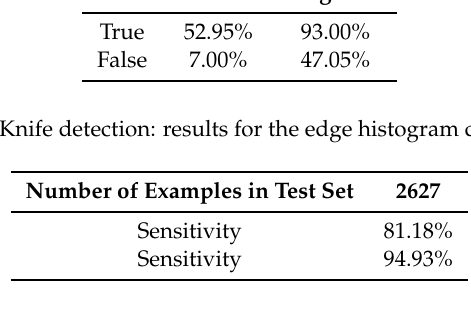
Table 4. Knife detection: results for the homogeneous texture descriptor.